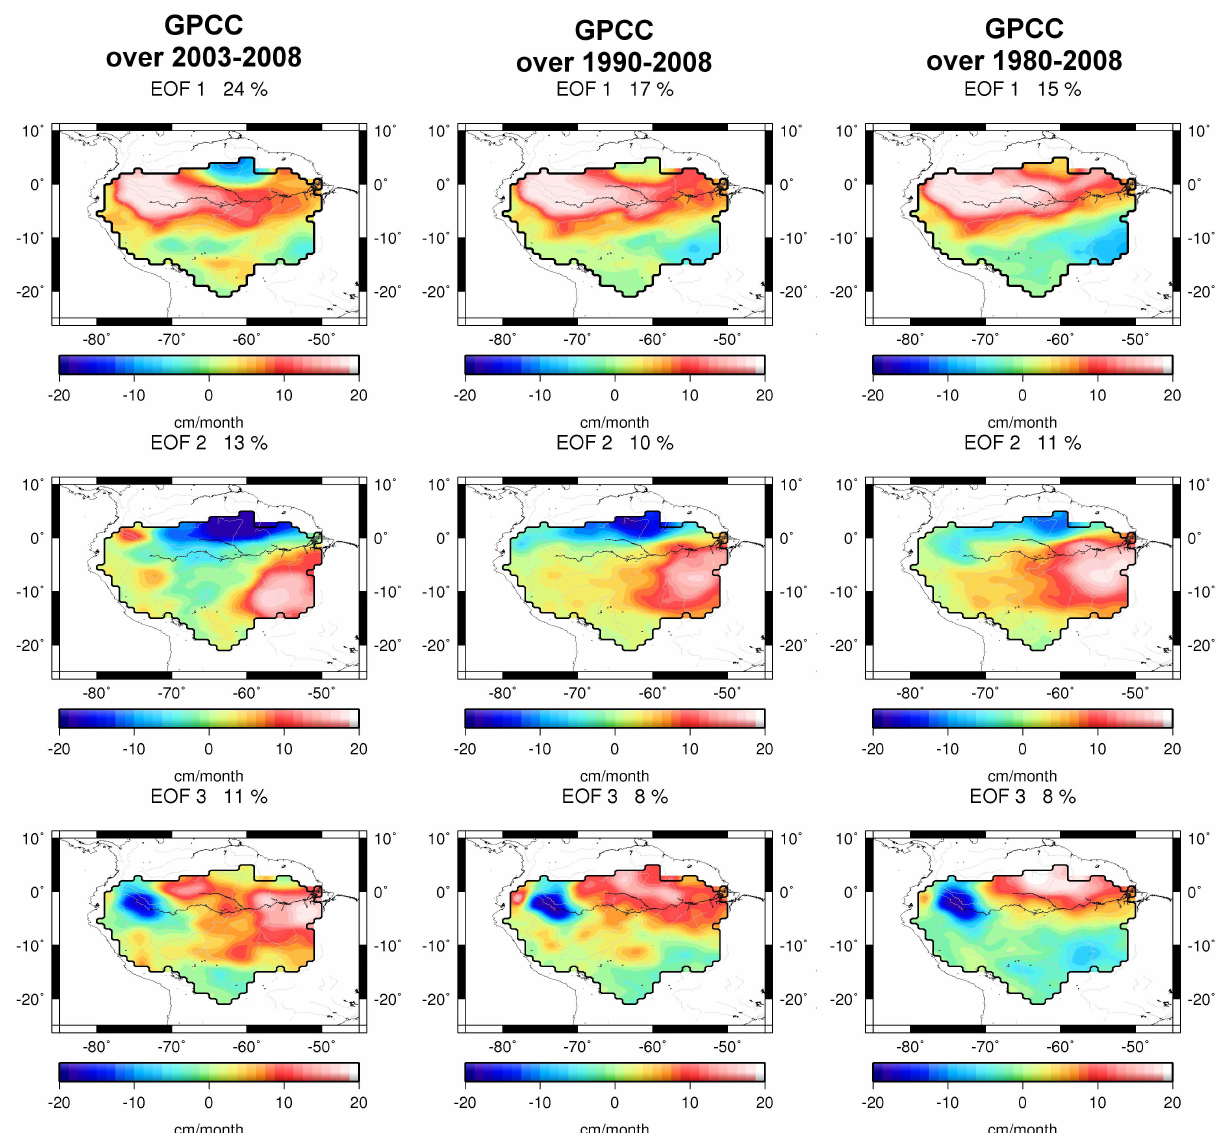
Fig. 5. Spatial patterns of the third EOFs computed from GPCC. EOF analysis over 2003–2008 (left panel), 1990–2008 (middle panel) and over 1980–2008 (right